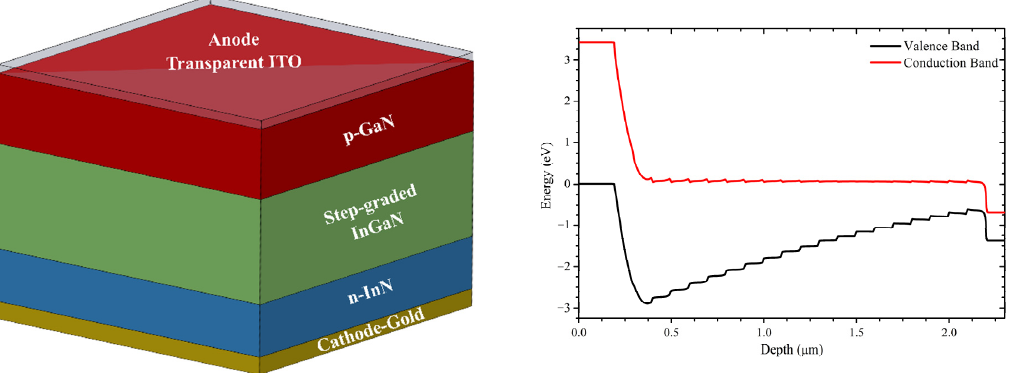
Figure 5. Solar cell structure to simulate ( left ) and band diagram of the structure under dark conditions ( right ).